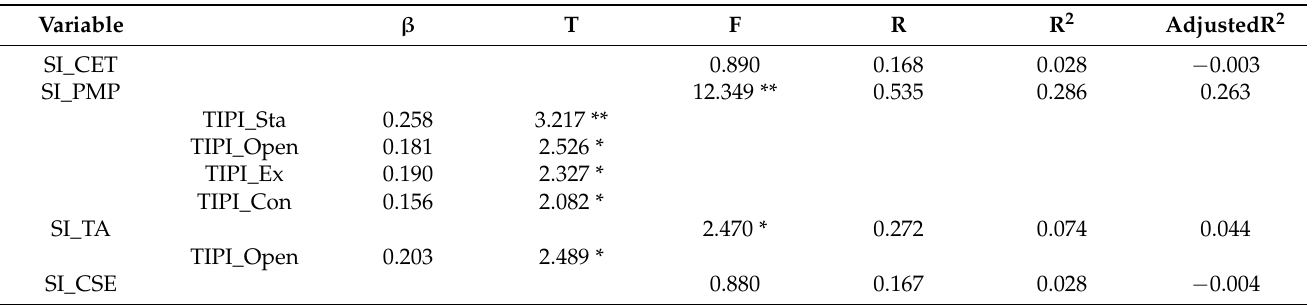
Table 3. Results of multiple regression analyses with personality traits as predictors of spiritual intelligence in specific domains.